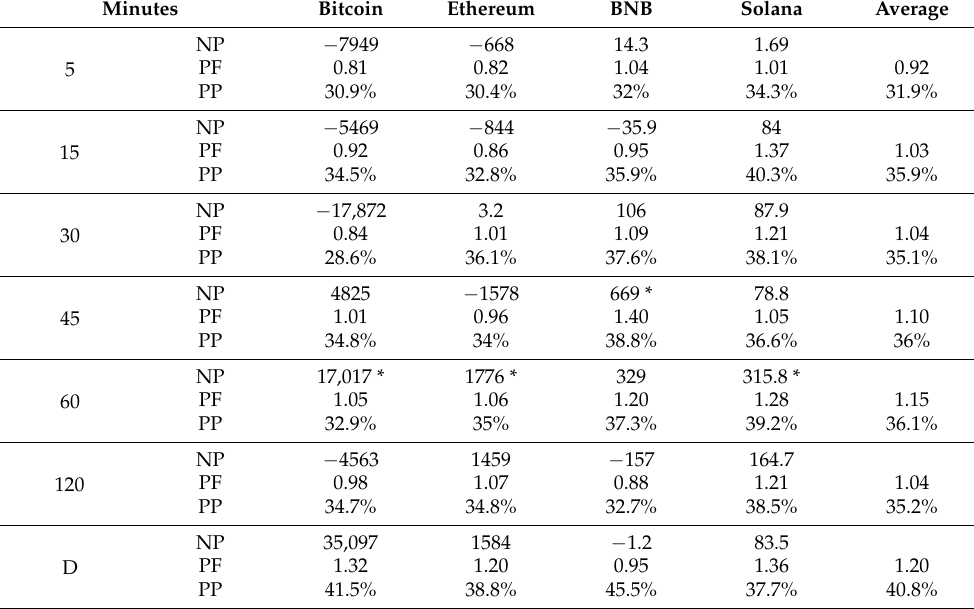
Table 3. Results of MACD trading algorithm.